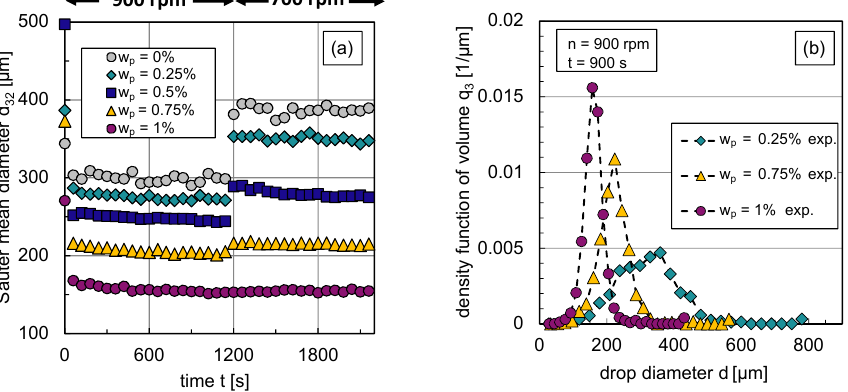
Figure 6. Experimental results: ( a ) Transient Sauter mean diameter with a step-wise change in stirrer speed from n = 900 rpm to n = 700 rpm at t = 1160 s, ( b ) stationary density-volume distributions q 3 at n = 900 rpm for particle mass fractions w p = 0.25%, w p = 0.75% and w p =